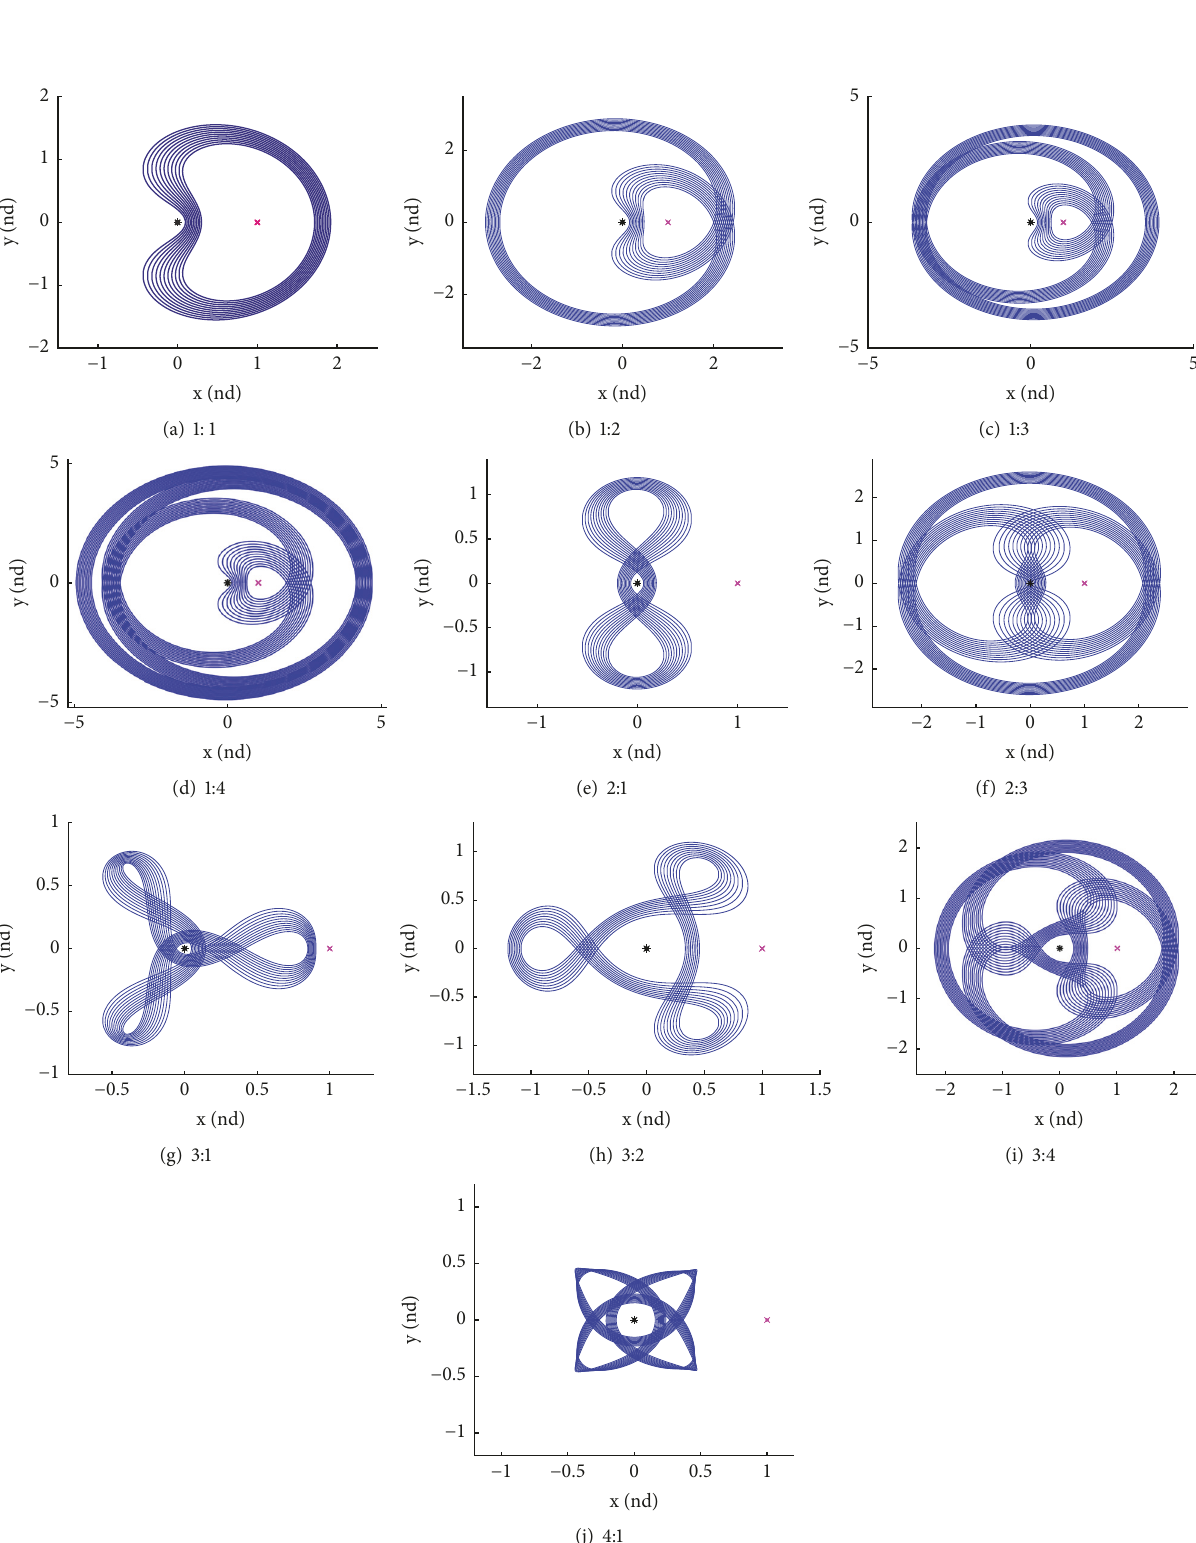
Figure 5: Resonant families in the Earth-Moon system plotted in GRC ( 𝜃 0 =